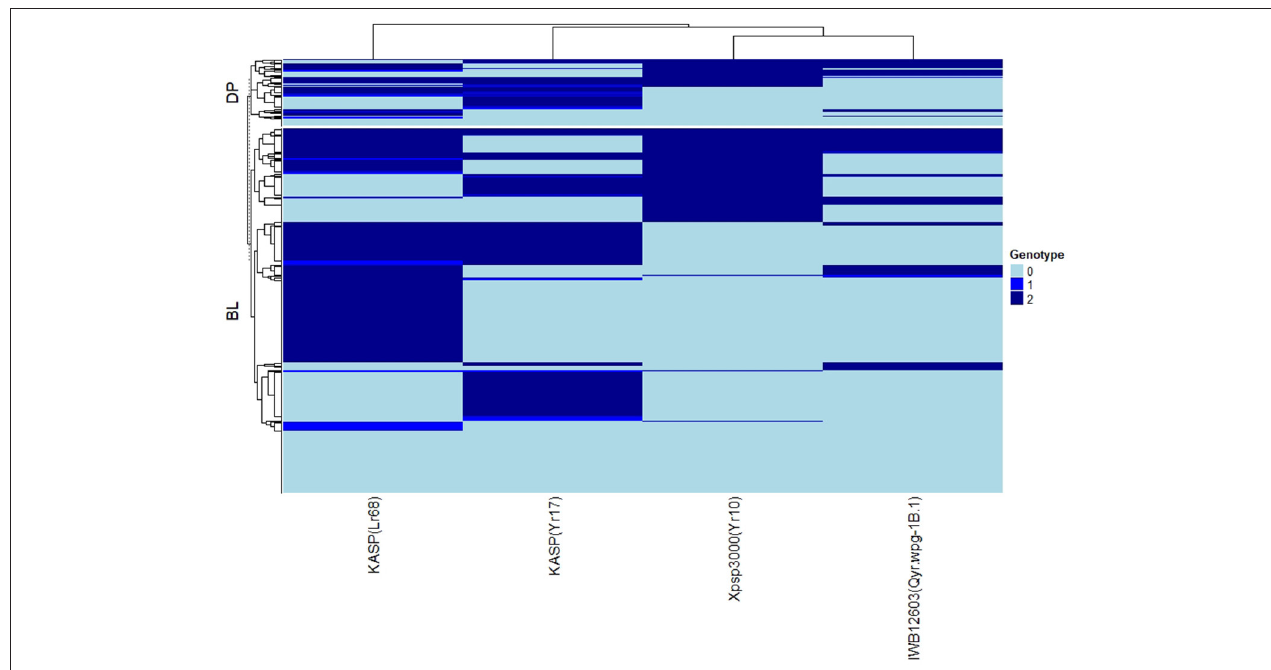
FIGURE 2 | Heat map and hierarchical clustering for lines in the diversity panel (DP) lines and breeding lines (BL) populations for the major rust markers: IWB12603(Qyr.wpg-1B.1), KASP(Lr68), Xpsp3000(Yr10), and KASP(Yr17). Genotype: 0, homozygous wild-type allele; 1, heterozygous with both alleles present; 2, homozygous resistant allele.